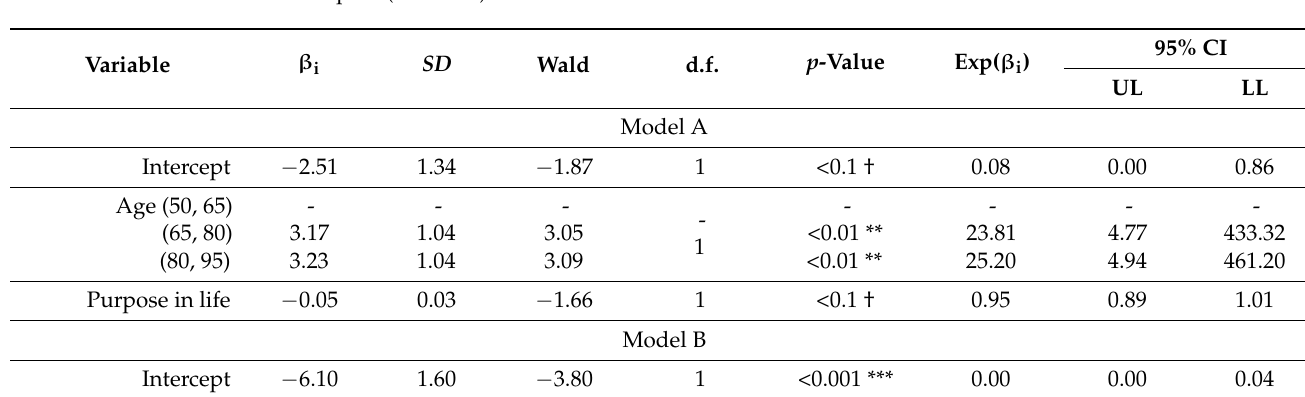
Table 5. Logistic regression models for the risk of cognitive decline adjusted for categorized age and pain (model